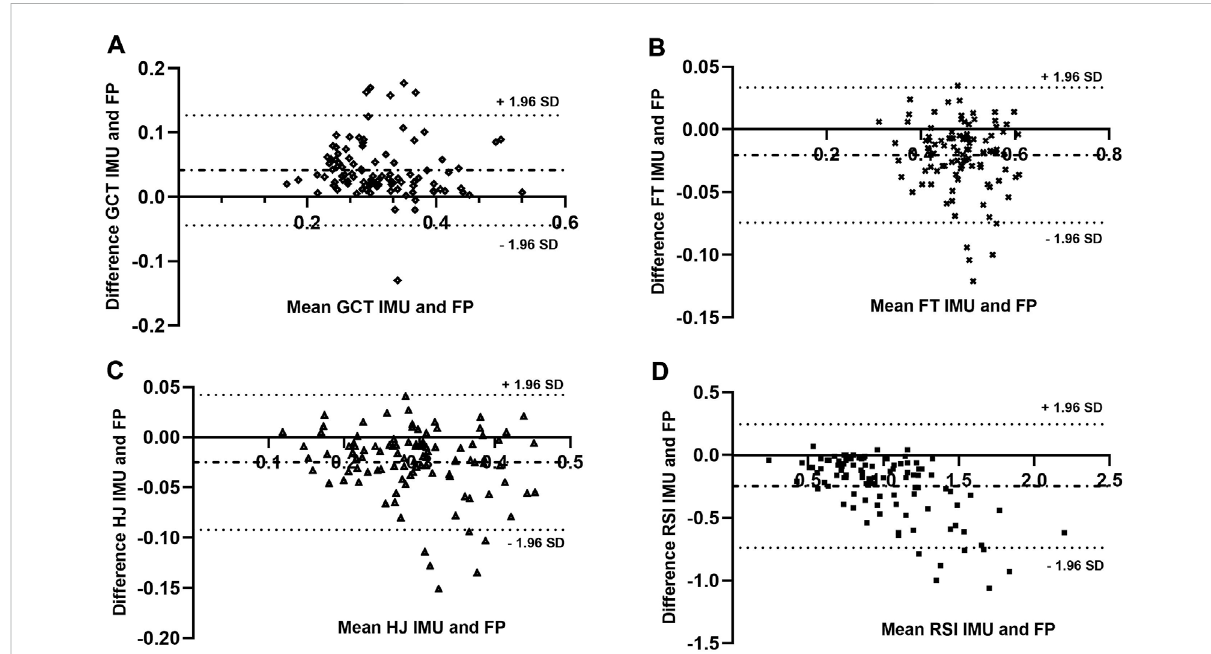
FIGURE 4 Bland Altman test. Measurements are obtained from the plate force and the OUTPUT sport. Representation (A) difference of Ground Contact Times (GCT) v/s mean GCT. Representation (B) difference of Flight Time (FT) v/s mean FT. Representation (C) difference of Jump Height (HJ) v/s mean of HJ. Representation (D) difference of Strength Reaction Index (SRI) v/s mean of RSI.